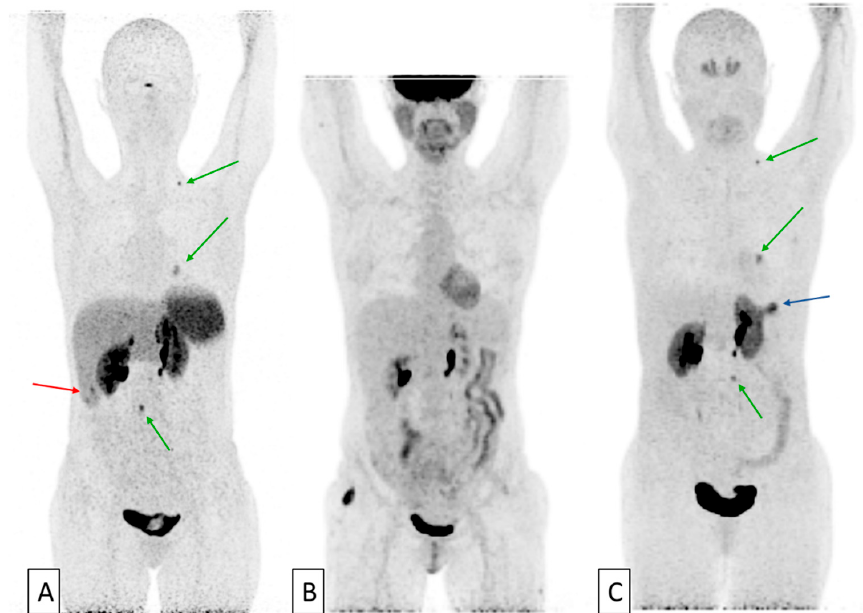
Figure 1. An example of a 46-year-old patient with pluri-metastatic intestinal neuroendocrine tumor (grade 2, ki67 at 4%). 68Ga DOTA-TOC ( A ), FDG-PET (18F-fluoro-deoxyglucose- positron-emission-tomography) ( B ) and FDOPA (18F-fluorodihydroxyphenylalanine) ( C ) imaging were realized. MIP (maximum intensity projections) images from the respective PET data sets are shown. The subject has positive on both FDOPA and somatostatine-receptor imaging, dominant disease which exhibits no FDG uptake (green arrows). One hepatic lesion was FDOPA-negative and 68Ga-DOTA-TOC-positive (red arrow) and one gastric lesion was FDOPA-positive and 68Ga-DOTA-TOC negative (blue arrow). Images courtesy of Pr C. Bodet-Milin.